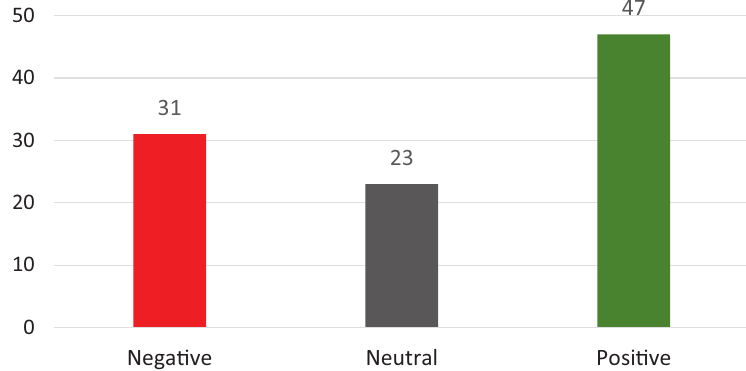
Figure 3. General position (2009–2021).